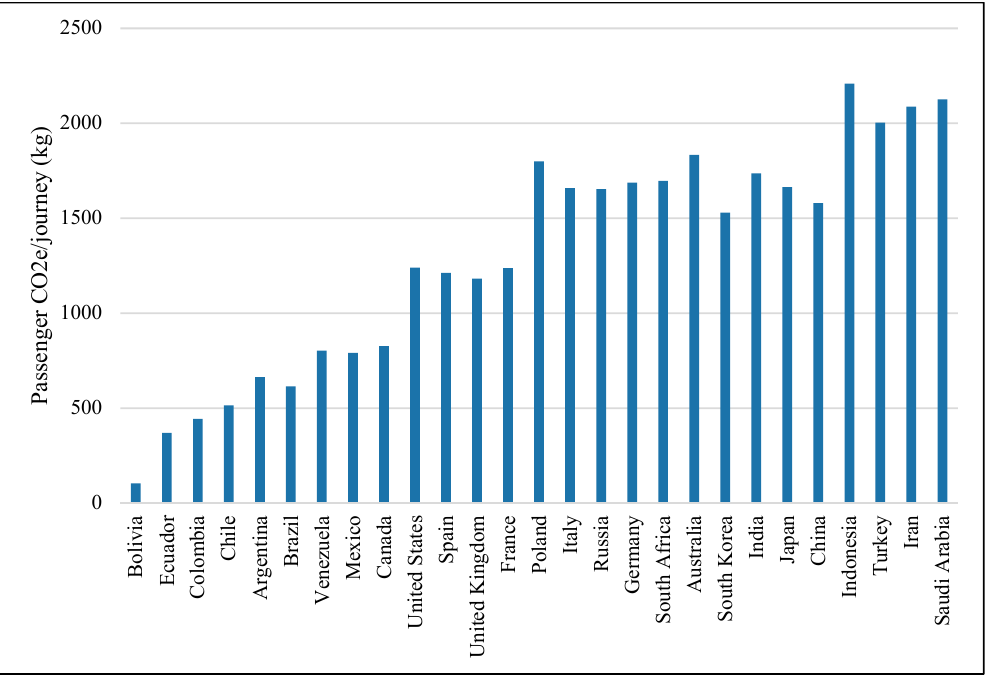
Figure 2. Carbon dioxide equivalent (CO2e) emissions generated in a round-trip flight from a representative airport city in each country to Cusco, Peru, for the purpose of visiting Machu Picchu.